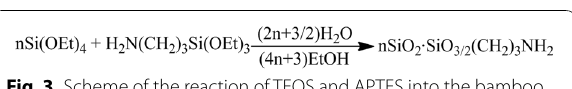
Fig. 3 Scheme of the reaction of TEOS and APTES into the bamboo